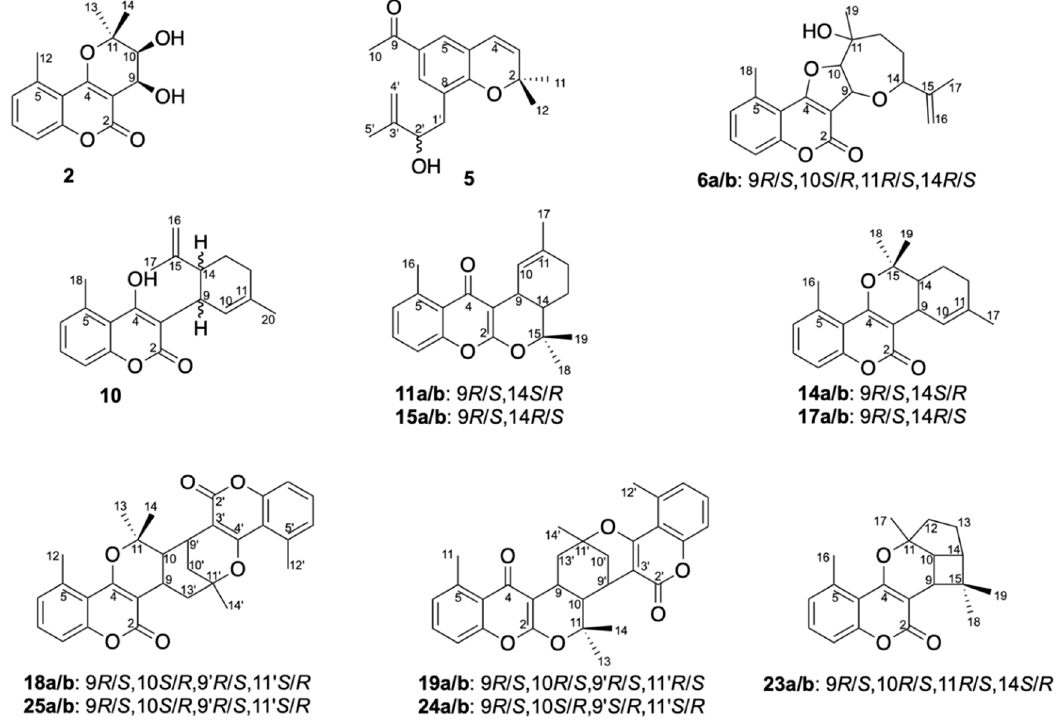
Figure 3. New prenyl- and geranyl coumarin derivatives 2 , 5 , 6 , 8 , 10 , 11 , 14 , 15 , 17 - 19 and 23 – 25 identified in the crude extract of Gerbera piloselloides .